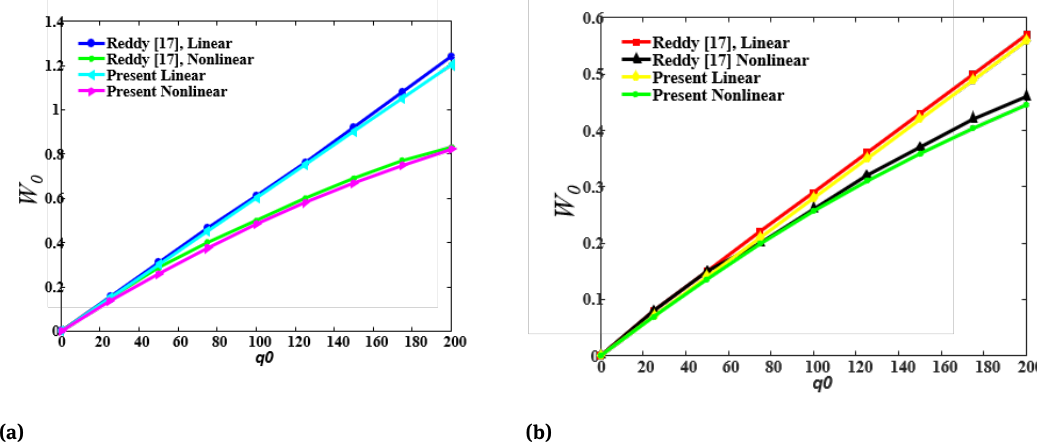
Figure 4: Validation for transverse maximum deflection of composite plate subjected to uniform pressure for a/h = 10, with stacking se- quence 0/45/ − 45/90 for (a) simply supported (SSSS2) and (b) clamped edges